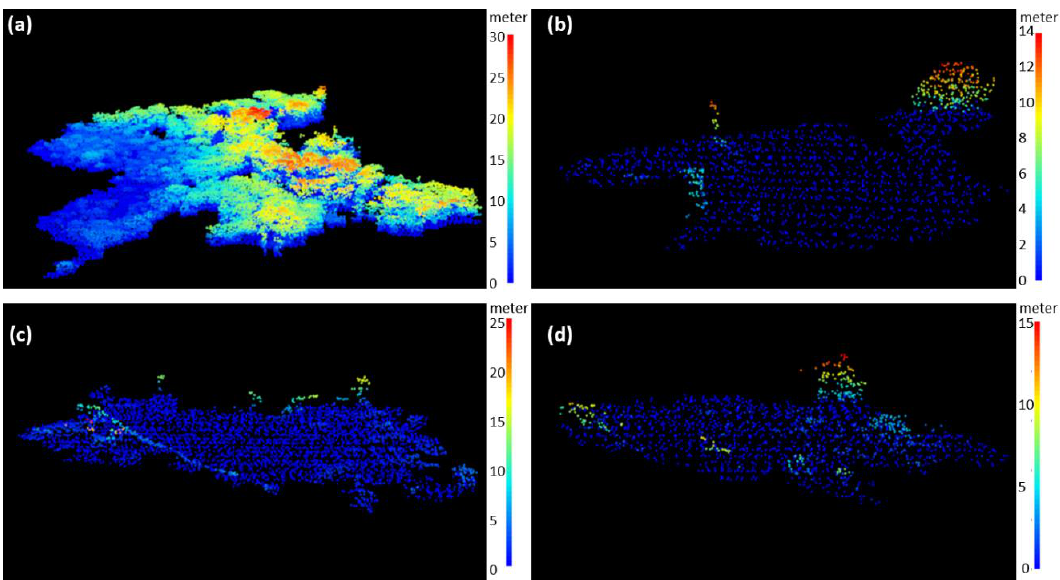
Table 4. Number of accurately labeled samples used for each run of model training for the second- step classification.